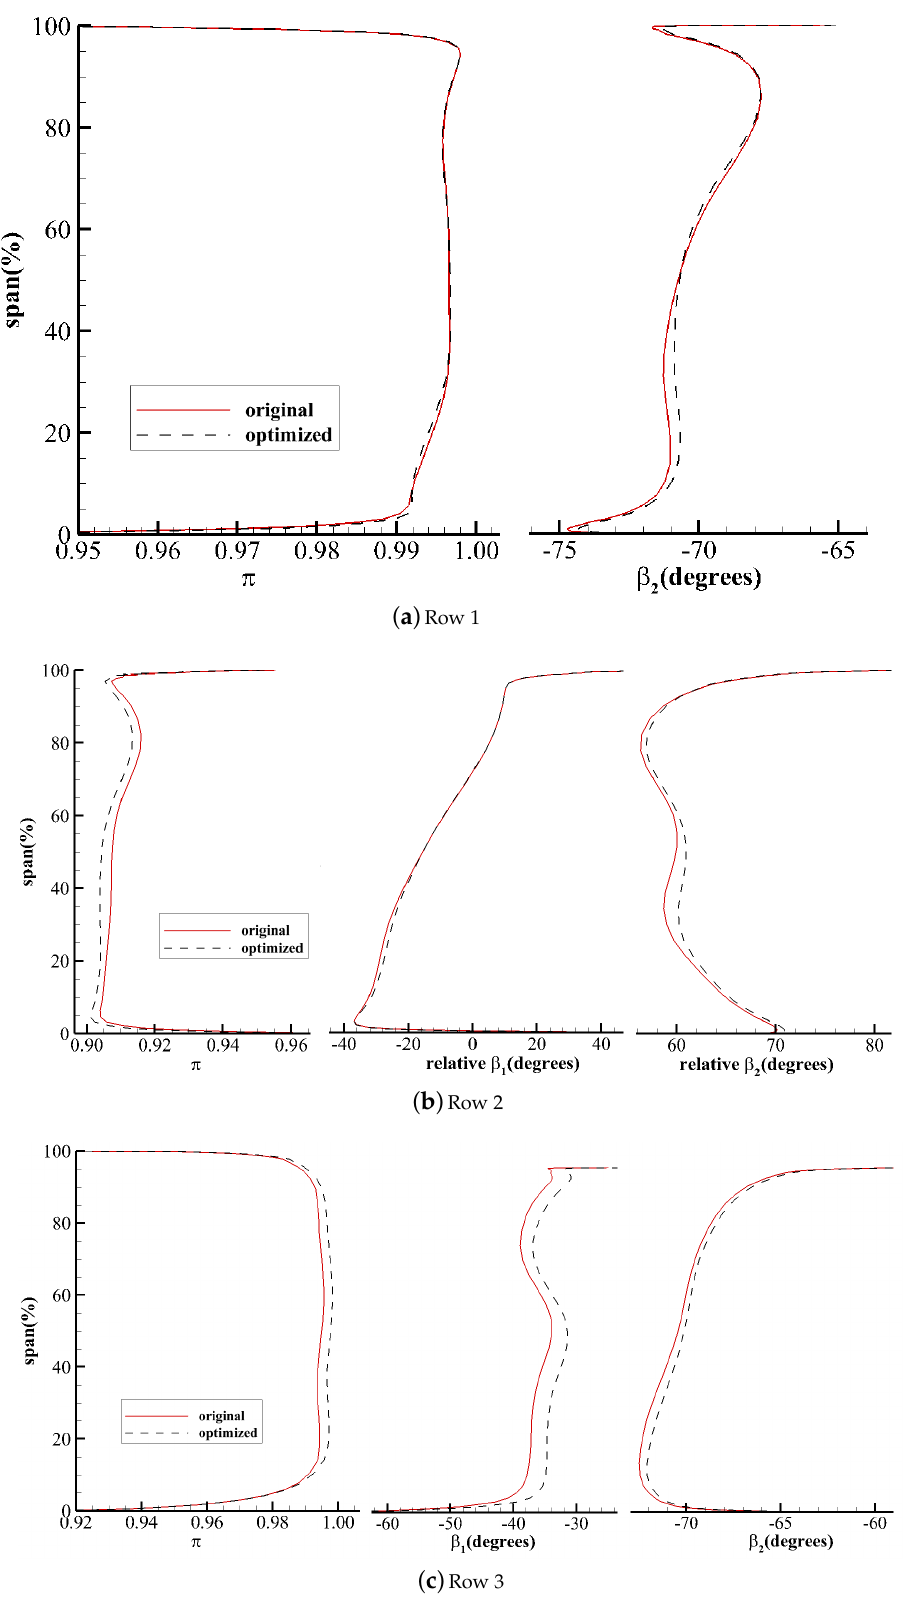
Figure 29. Radial distributions of total pressure ratio, inlet, and outlet flow angles in each row for the Aachen